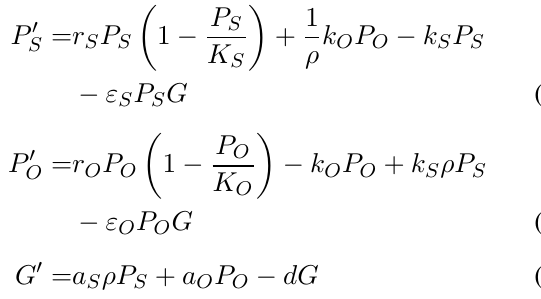
dynamics of the parasite load in the skin tissue ( P S ( x ) ), the parasite load in the bone marrow ( P O ( x ) ), and the IgG concentration ( G ( x ) ), where x is the time-since-infection. The subscript S will indicate skin tissue, while the subscript O will indicate the bone marrow. We first introduce the model below and then we explain and motivate